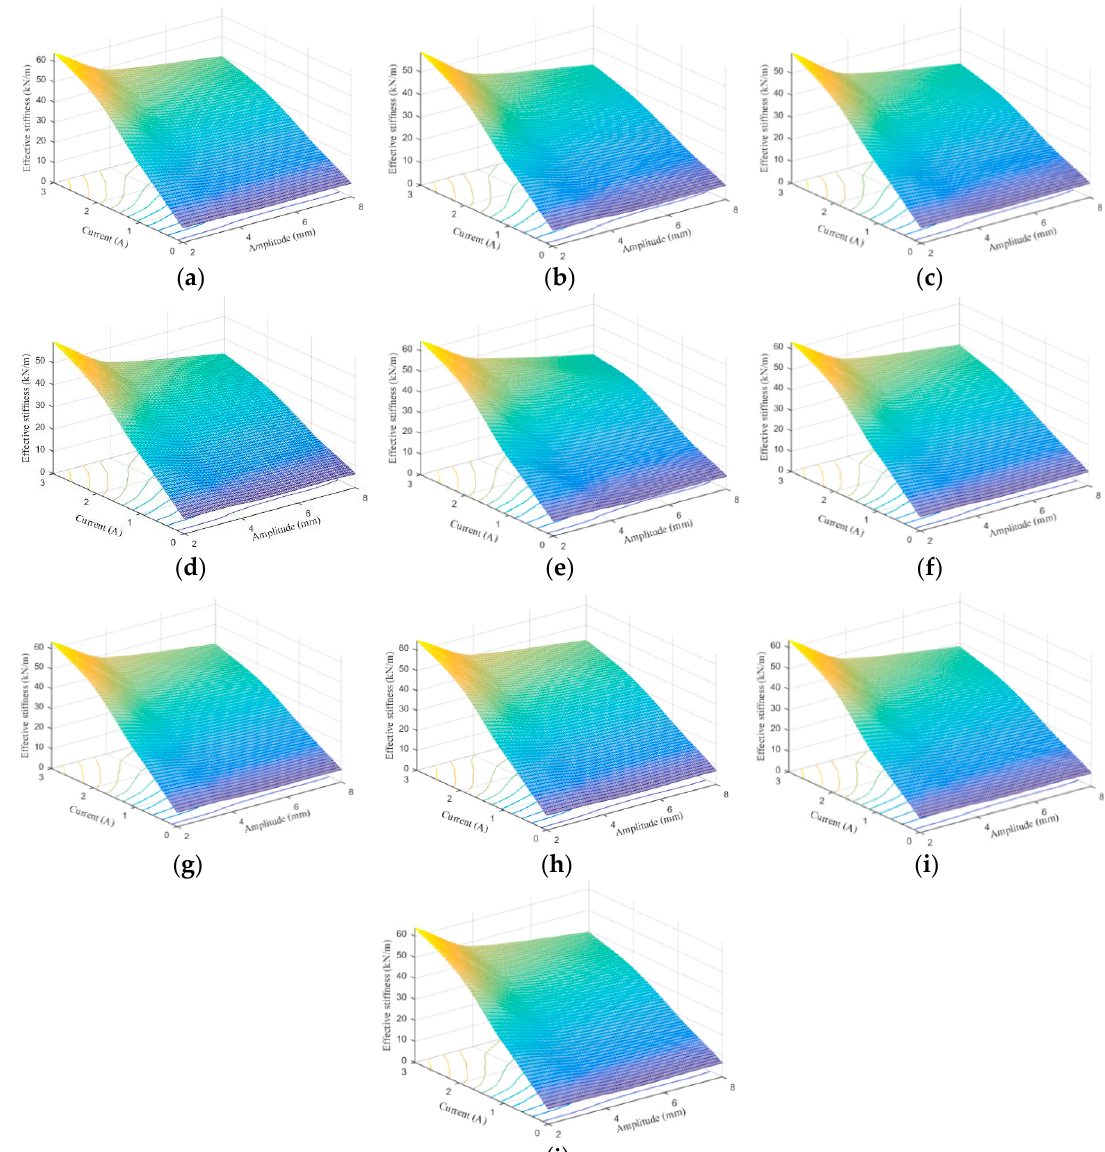
Figure 25. Effective stiffness estimation results of 1 Hz loading frequency. ( a ) Experimental measurement, ( b ) Kelvin–Voigt model, ( c ) four-parameter viscoelastic model, ( d ) rheological model, ( e ) BW model, ( f ) improved BW model, ( g ) Dahl model, ( h ) improved LuGre friction model, ( i ) strain stiffening model, and ( j ) hyperbolic hysteresis model.